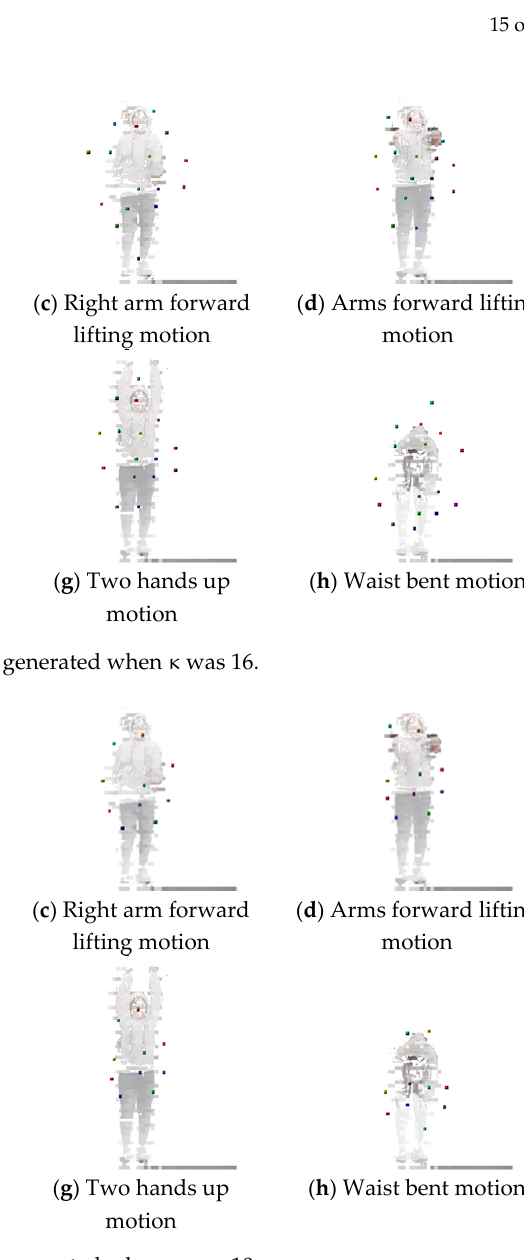
Figure 13. 3D landmarks generated when κ was 6.